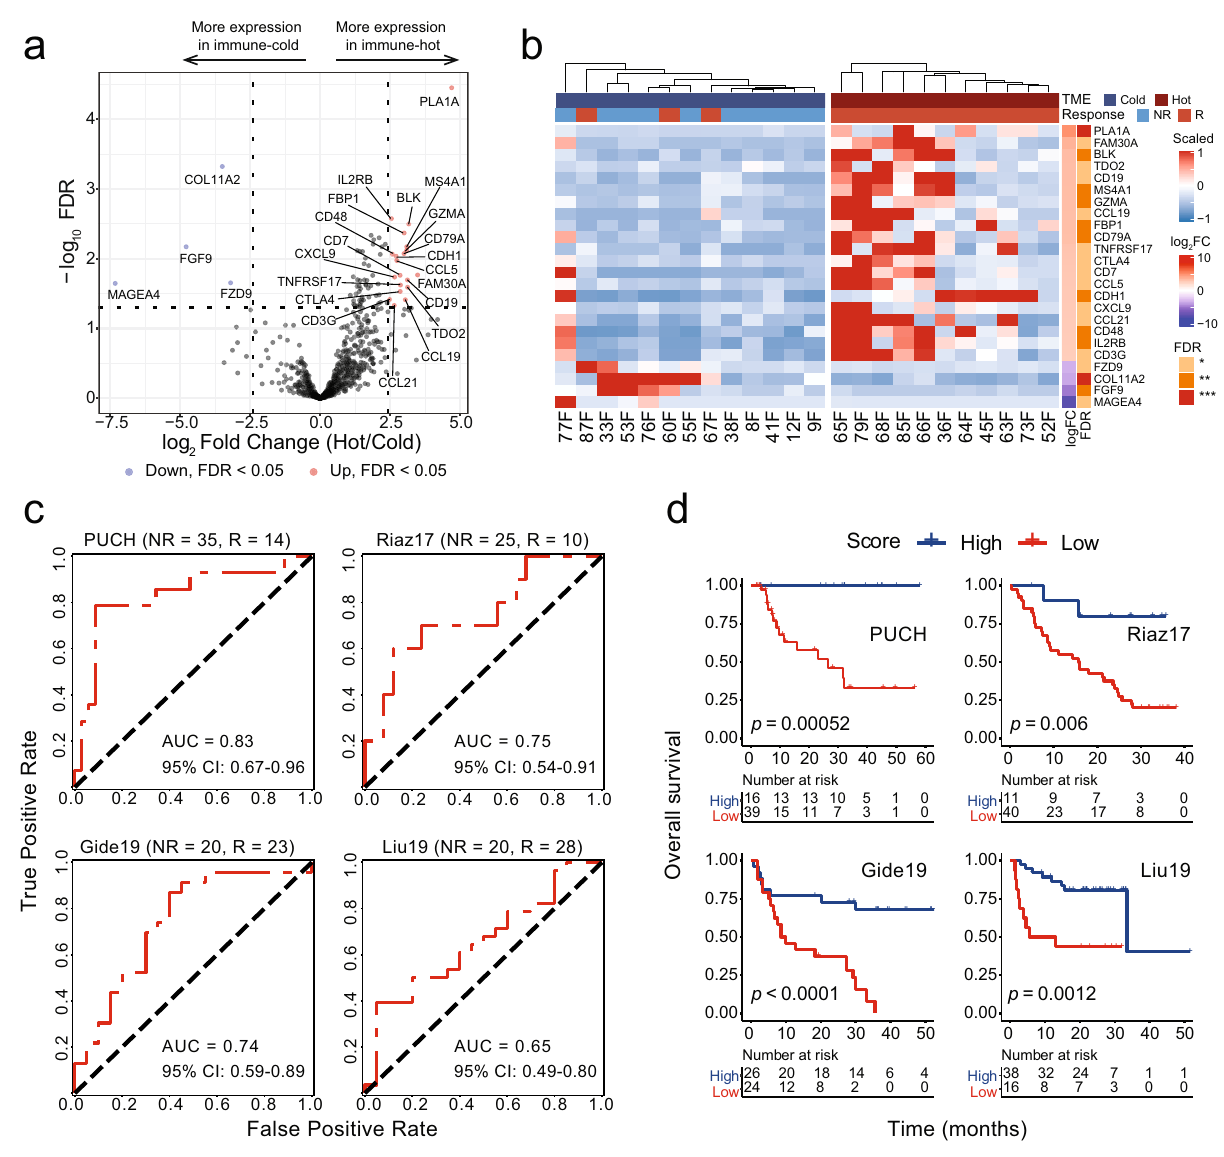
Fig. 5 Prognostic impact of gene signature derived from tumor microenvironment (TME) archetypes. a Volcano plot showing the upregulated genes (red) and downregulated genes (blue) in patients with immune hot TME. b Heatmap depicting the expression of 24 differential expression genes (DEGs, 20 upregulated genes, 4 downregulated genes) from PUCH patients classi fi ed as immune cold and immune hot groups. For panels ( a ) and ( b ), n = 13 for the immune cold group and n = 11 for the immune hot group. c The receiver operating characteristic (ROC) curve of sensitivity versus 1 − speci fi city of the prediction performance of prognostic score calculated by the 24 DEGs for PUCH dataset (discovery cohort, nonresponsders NR = 35, responders R = 14) 26 and other three public datasets (i.e., Riaz17 29 (NR = 25, R = 10), Gide19 30 (NR = 20, R = 23), Liu19 31 (NR = 20, R = 28)). Patients with stable disease (SD) were not included. AUC area under curve. d Kaplan – Meier curves of overall survival in melanoma patients with high versus low prognostic score calculated by the 24 DEGs for PUCH dataset ( n = 55) 26 and other three public datasets (i.e., Riaz17 29 ( n = 51), Gide19 30 ( n = 50), Liu19 31 ( n = 54)). P values calculated using the log-rank test. PUCH Peking University Cancer Hospital and